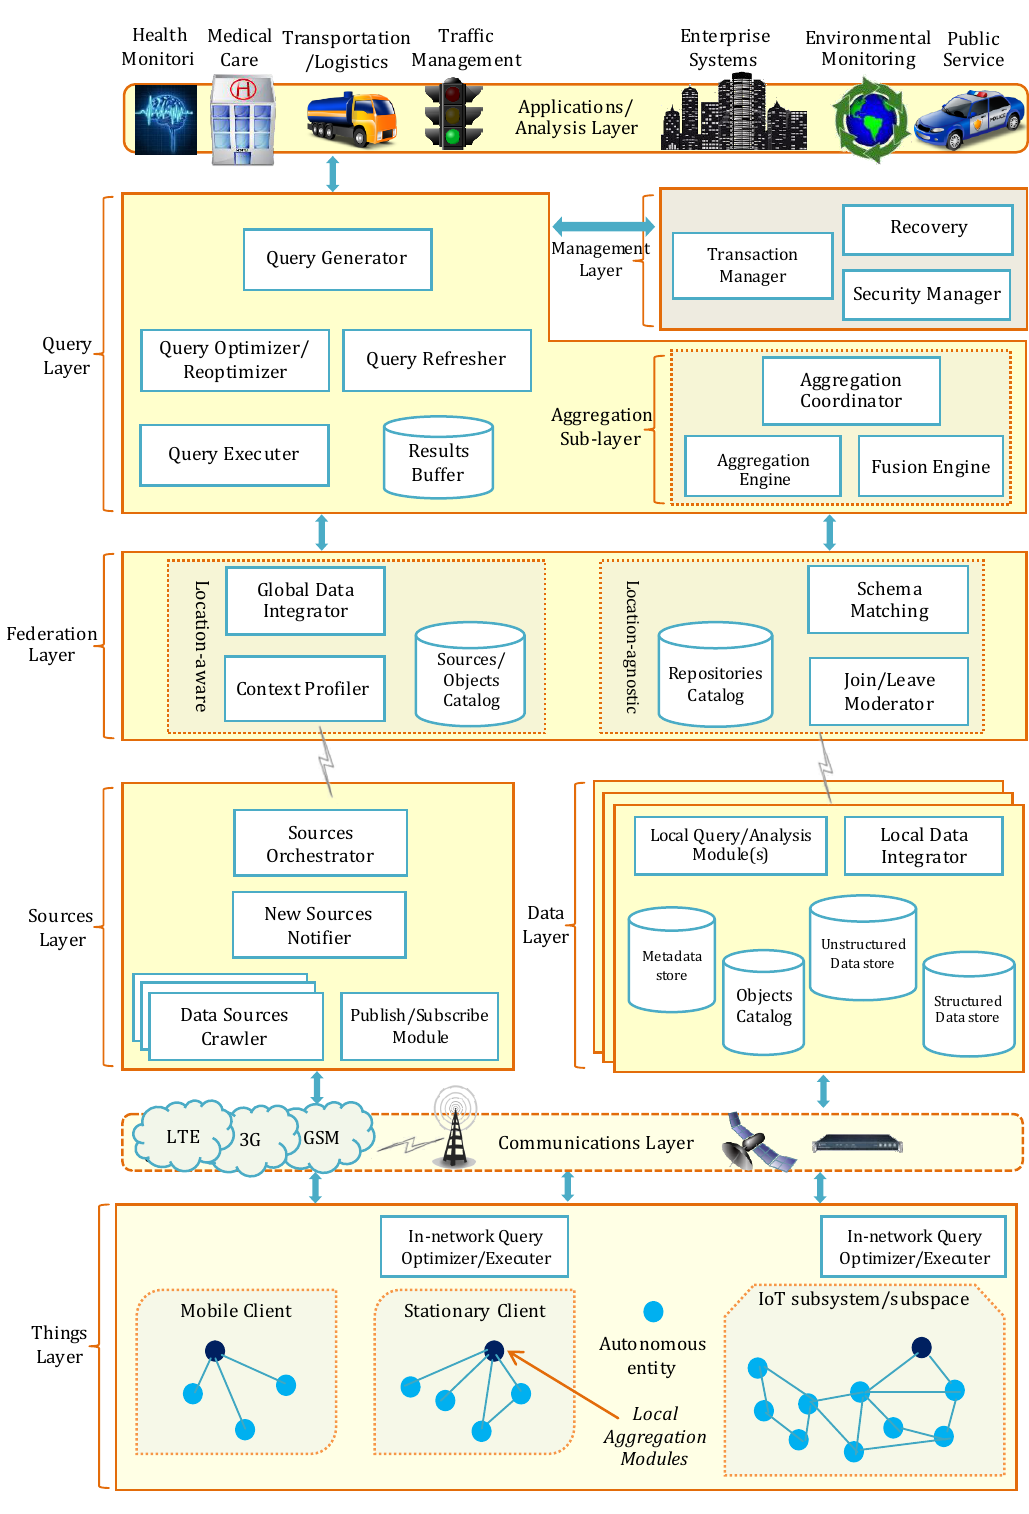
Figure 4. IoT data management